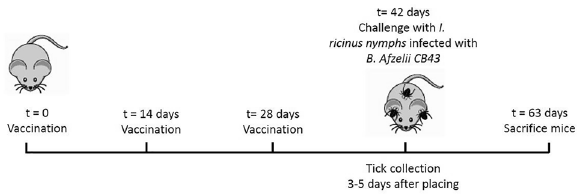
Figure 5. Schematic design of the vaccination study. The study consisted of 3 experimental groups of 8 mice each. The first group was vaccinated with recombinant BB0405, the second group was received a tattooed DNA vaccination with BB0405 and the third group received an empty vector DNA vaccination as a control. Mice were vaccinated at t = 0, t = 14 and t = 28 days. They were challenged with infected ticks 2 weeks after the last booster vaccination and sacrificed at day